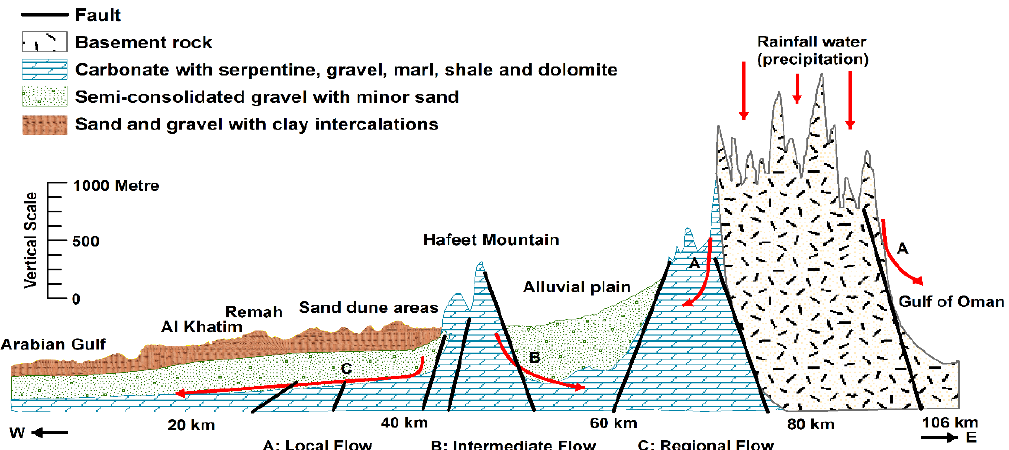
Figure 4. The different formations are: ( A ) Lithological formation of groundwater-bearing rocks; ( B , C ) east and west topographic profile and showing the groundwater flow path (modified after Elmahdy and Mohamed [24]).